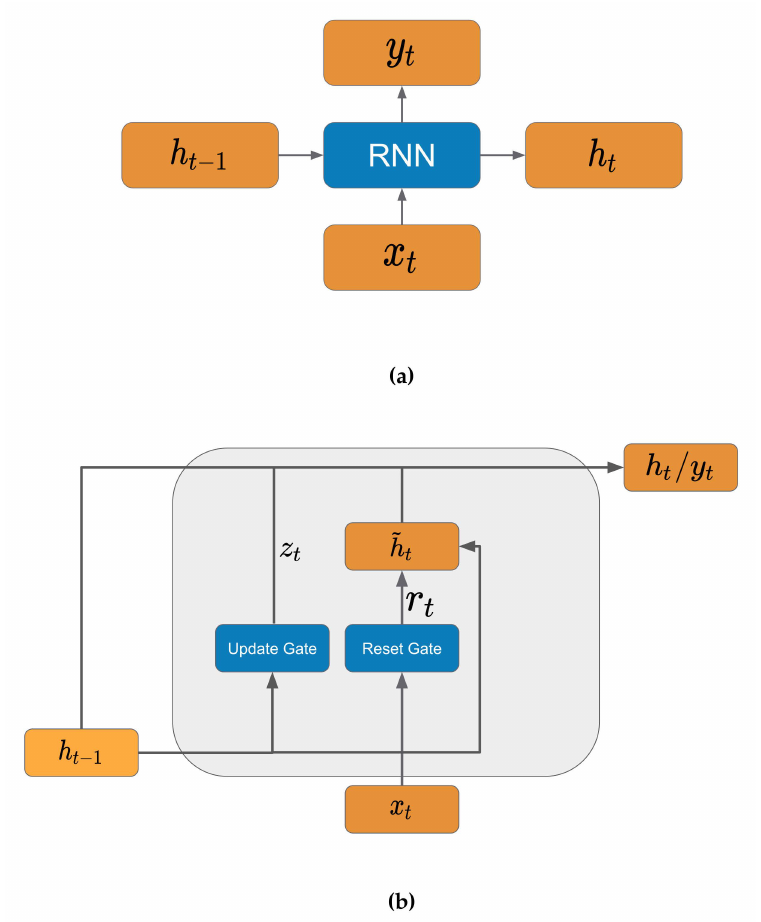
Figure 8. Basic Architecture of Recurrent neural network ( a ) and Architecture of Gated Recurrent Unit ( b